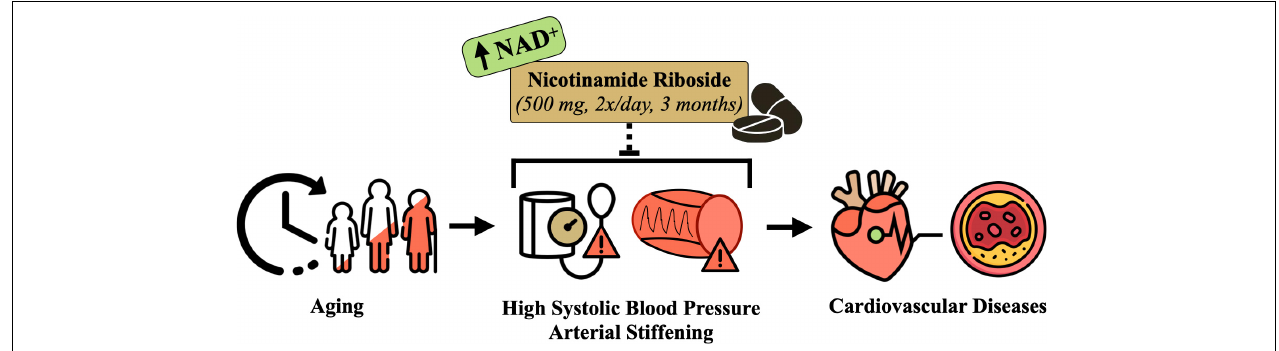
FIGURE 1 | Conceptual overview of the hypothesized effects of nicotinamide riboside supplementation for treating elevated systolic blood pressure and arterial stiffness in midlife and older adults. Designed with resources from flaticon.com.